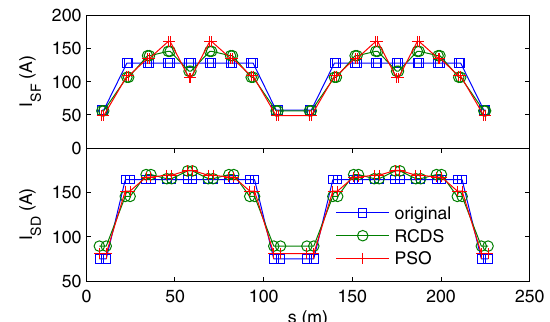
FIG. 1. History of objective function values of all evaluated solutions during the RCDS optimization (top) and the PSO optimization (bottom).